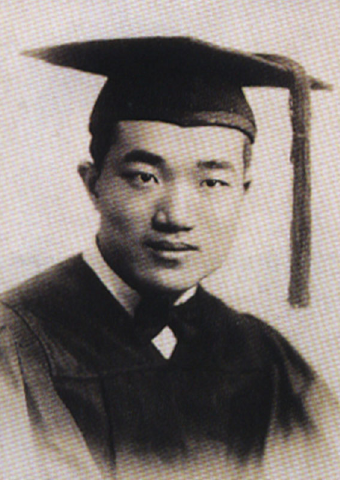
Figure 3. Graduating from Jinling University with an honor BSc in Forestry in 1933.